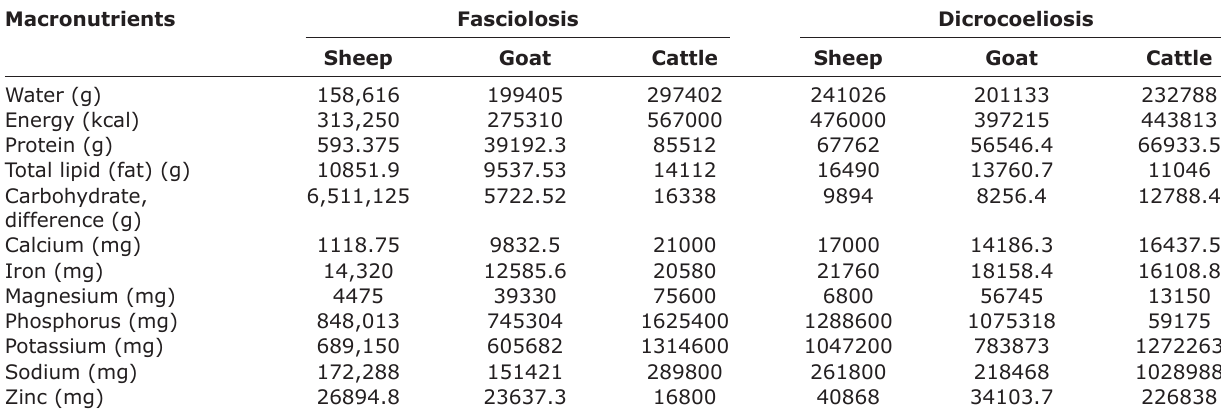
Table-4: The macronutrients and mineral waste in livers infected with Fasciola hepatica , Fasciola gigantica , and Dicrocoelium dendriticum in